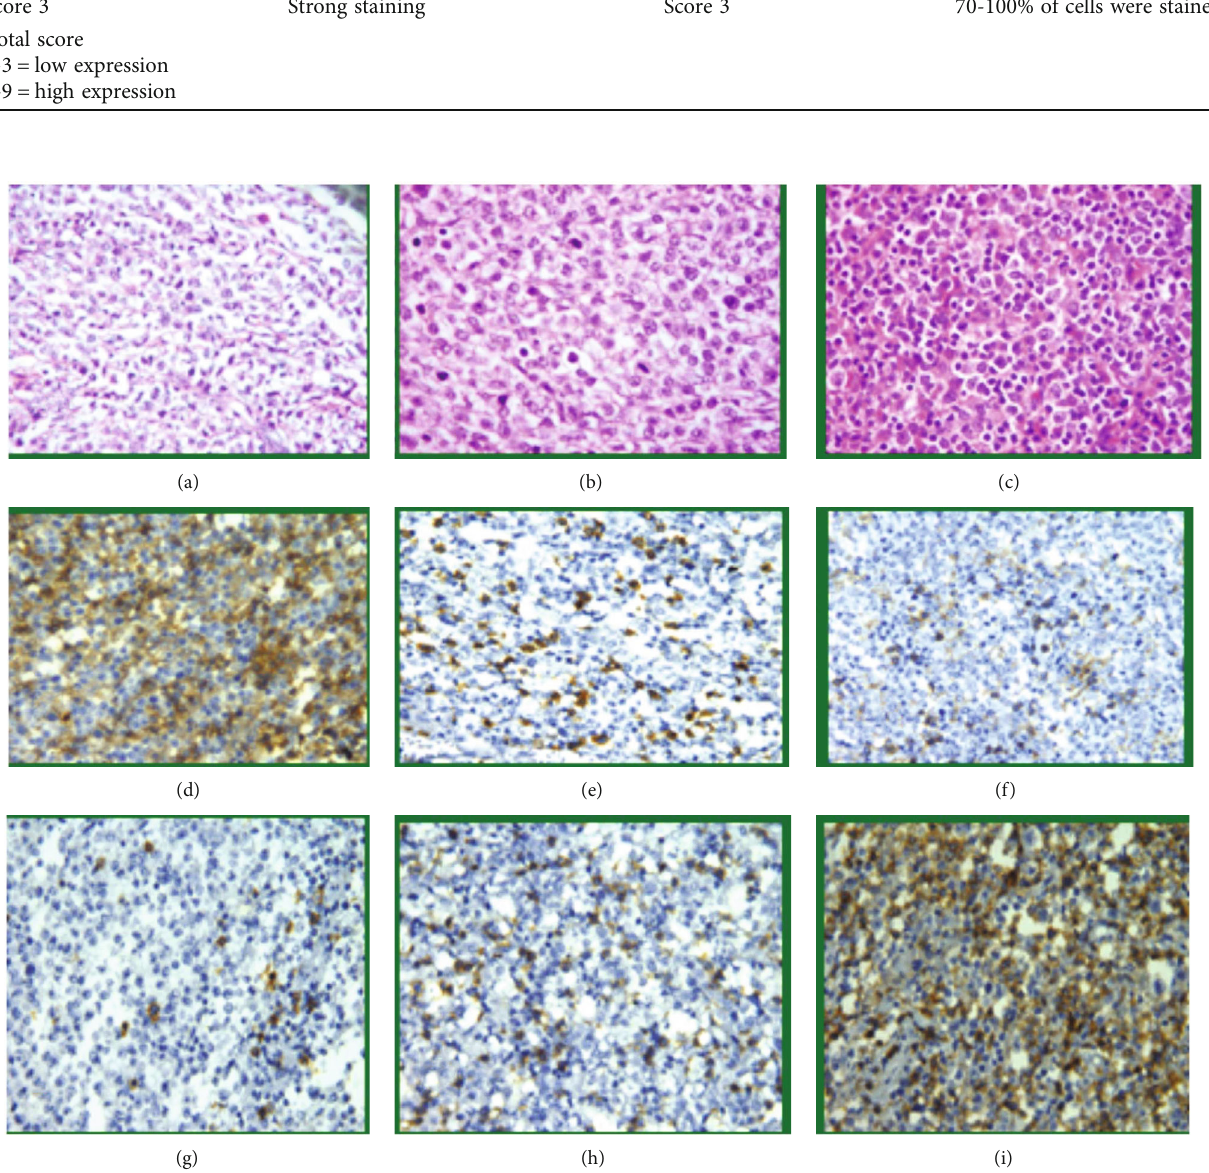
Figure 1: DLBCL with reactive appearing lymphocytes in the background (a – c, × 200); IHC staining for CD4 showed the variable intensity of CD4-positive T helper cells in the background of lymphoma cells (high, moderate, and low (d – f, respectively, × 200)). IHC for CD8 showed the variable intensity of CD8-positive cytotoxic T cells in the background of lymphoma cells (low, moderate, and high (g – i, respectively, × 200)).